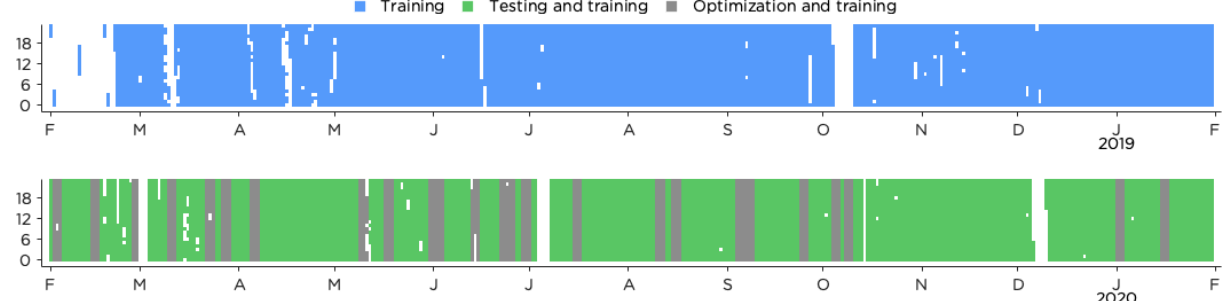
Figure 2. Availability of lidar observations (after quality control) and forecasts from AROME for the period 1 February 2018 to 31 Jan- uary 2020. The time period is split into 1 year that was only used for training (1 February 2018 to 31 January 2019) and 1 year that was used for training, optimization and testing (1 February 2019 to 31 January